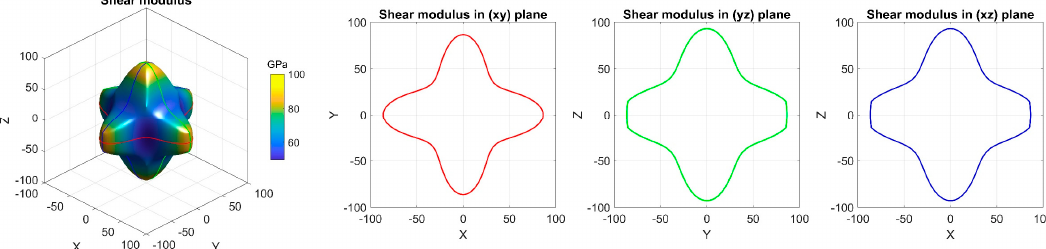
Figure 12. The calculated directional dependent shear modulus for the full Heusler compound Pd 2 CoAl in L2 1 -type tetragonal